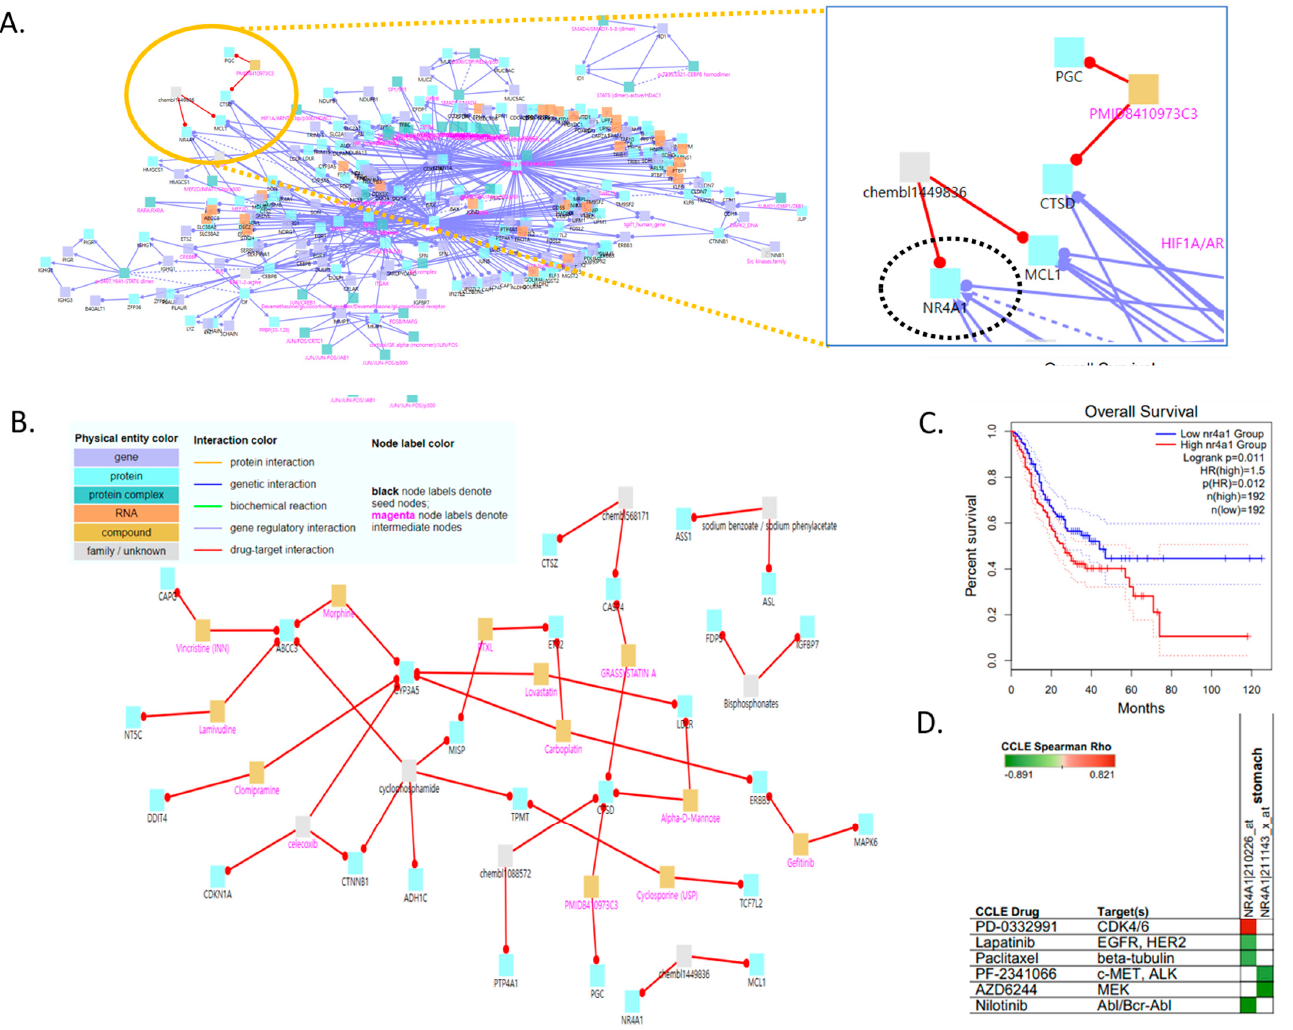
Figure 5. Vulnerabilities of non-defined telomere maintenance mechanism NDTMM type for cancer therapy. ( A ) Gene regulatory interaction network for NDTMM type of adenocarcinoma constructed using ConsensusPathDB. (CPDB) ( B ) Drug–target interaction for NDTMM type of adenocarcinoma. ( C ) Kaplan–Meier plots show overall survival rates for high and low NR4A1 expression ( p < 0.011). ( D ) Drug and target genes for gastric cell line molecular subtypes from the Cancer Cell Line Encyclopedia (CCLE). High drug sensitivity is indicated in green (negative correlation).